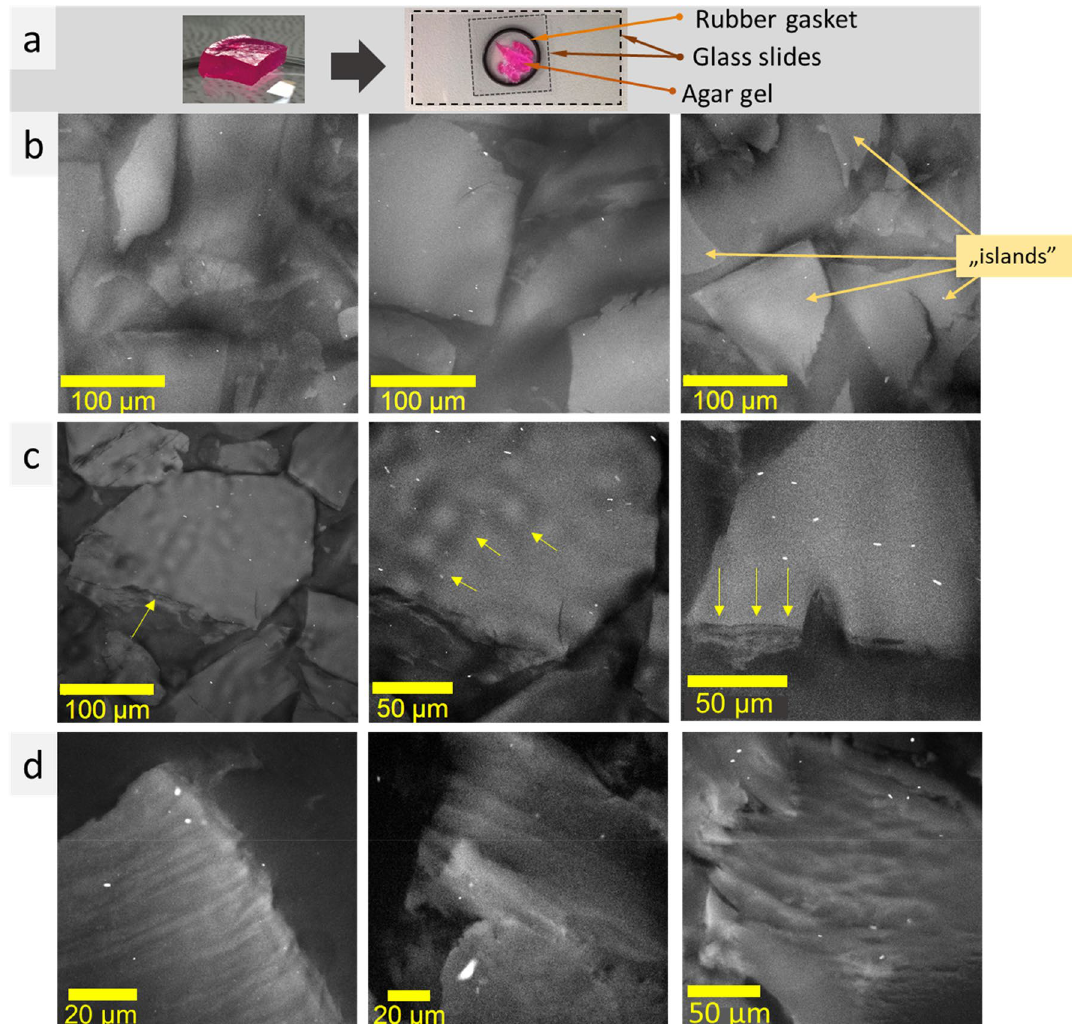
Figure 2. Photos of a piece of agar gel with rhodamine B and glass slides with the gel prepared for confocal LSM measurements ( a ); confocal LSM images of agar gel with rhodamine B (excitation wavelength 561 nm, laser power ~ 0.14 mW): “islands” ( b ), globular ( c left and central images) and layered structures ( c right); ordered microstructures ( d ). Contast and brigthness were